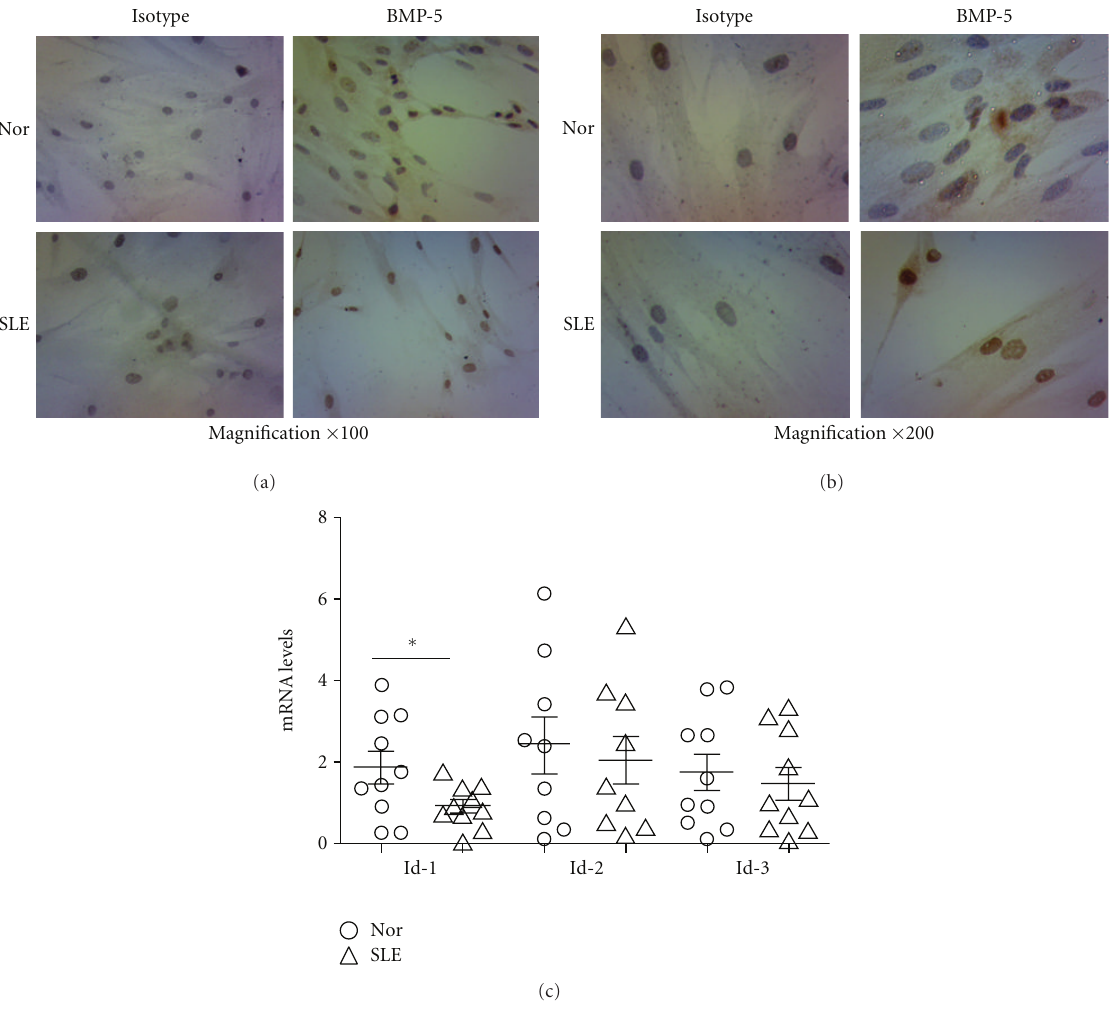
Figure 5: Immunohistochemical detection of BMP-5 protein and mRNA levels of Id-1, Id-2, Id-3 in BMMSCs. (a) magnification × 100, (b) magnification × 200. The left pictures are isotype controls, the right are BMP-5 immunohistochemical staining. (c) qRT-PCR studies of the expression of Id-1, Id-2, and Id-3 in BMMSCs from SLE patients and normal controls ( n = 10). ∗ P < 0 . 05 by nonparametric test of SPSS 16.0 software. SLE: systemic lupus erythematosus, Nor: normal